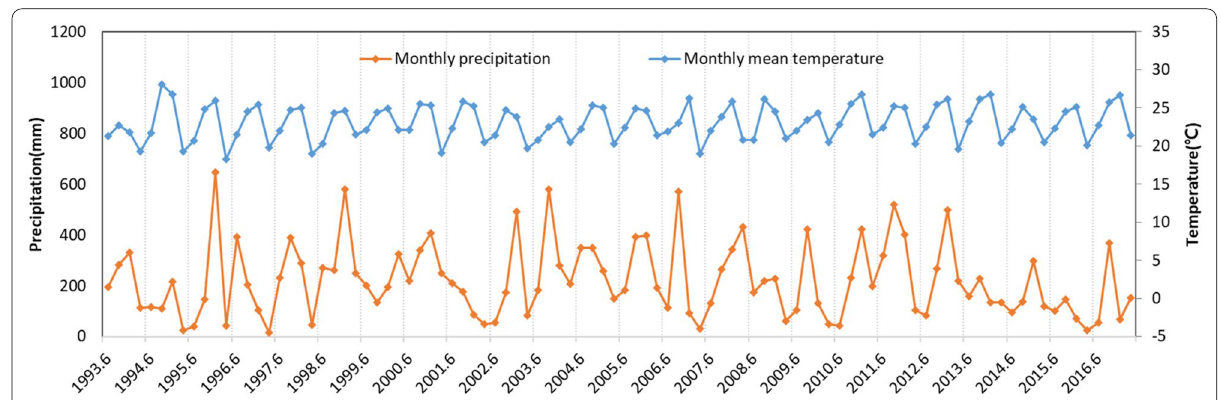
Fig. 11 Observed data of the monthly precipitation and mean temperature during the flood season from June 1993 to September 2016.